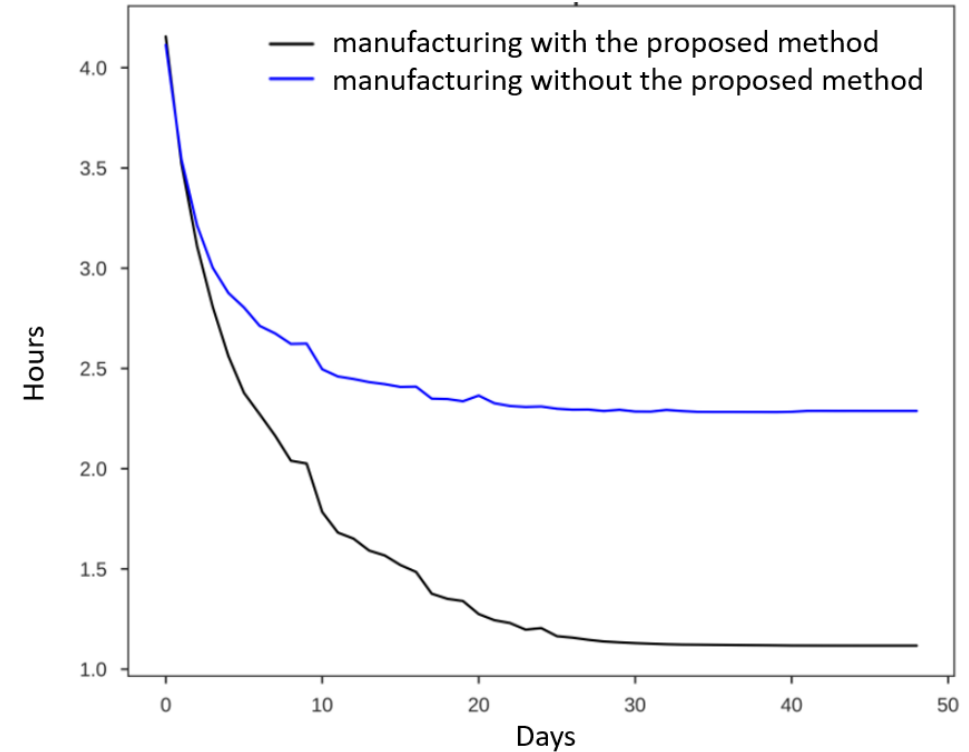
Figure 12. The experimental results.